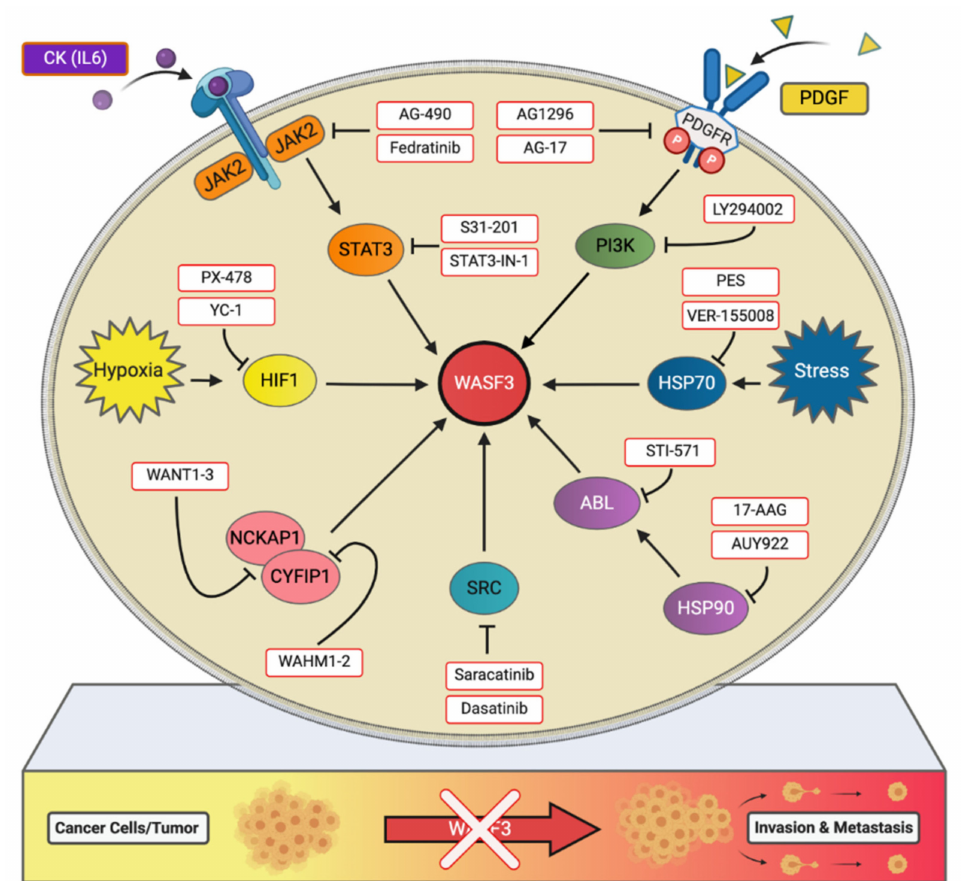
Figure 3. Different inhibitor strategies to abolish the activation of WASF3 signaling and suppress metastasis. Annotations in red identify nodes in this schema for which drugs are available to suppress WASF3 signaling. Only a few representative drugs are shown in each